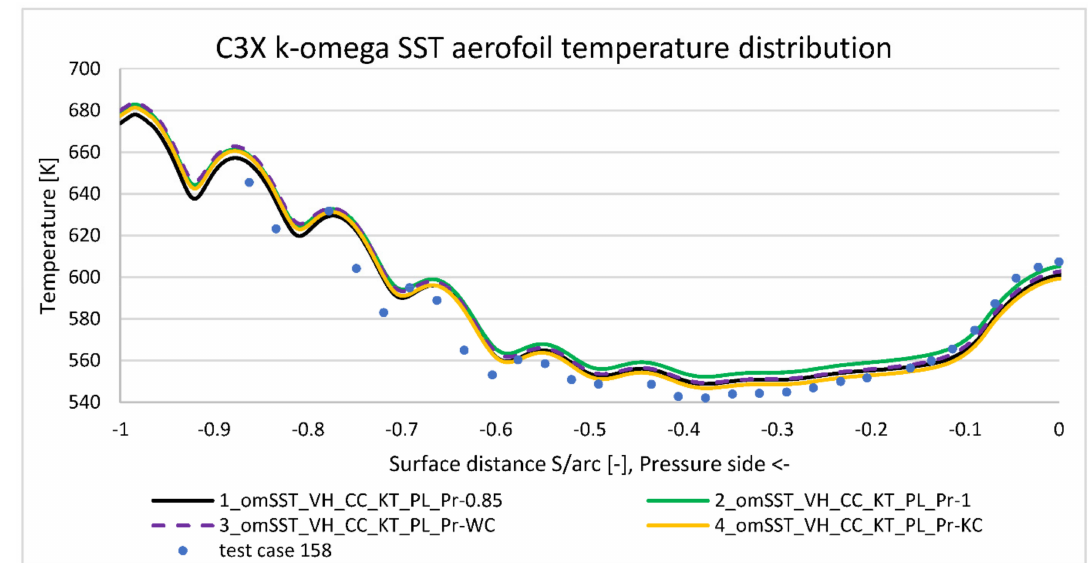
Figure 15. Pressure side temperature distribution comparison according to Prandtl number correction.